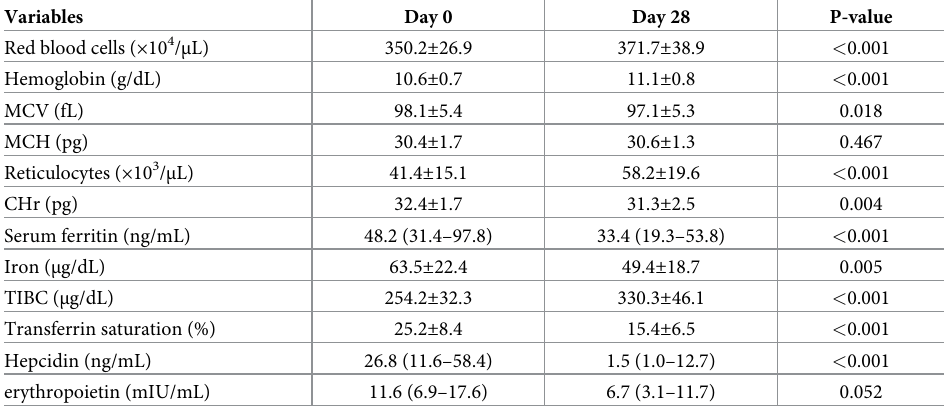
Values are shown as the mean ± standard deviation or median (interquartile range).